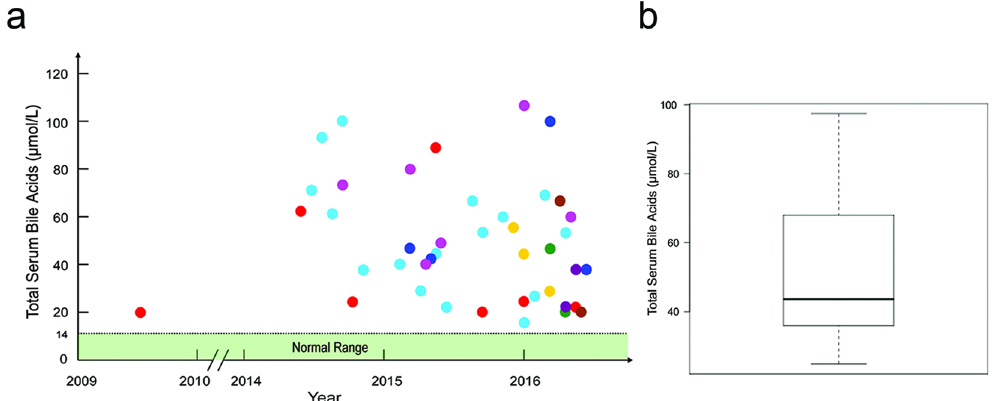
Figure 1. Levels of total serum bile acids (tsBAs) tested at the hospital lab and the Kingmed Diagnostics lab. ( a ) Scatter plots of tsBAs among the eight individuals who had a homozygous p.Ser267Phe genotype in SLC10A1 tested at the hospital lab. All tests were performed on serum from blood taken first thing in the morning after at least 8 hours of fasting. Red dot: individual 1, light blue: individual 2, dark blue: individual 3, light purple: individual 4, yellow: individual 5, dark green: individual 6, brown: individual 7, and dark purple: individual 8. The light green area shows the normal range for total serum bile acids (0–14 μ mol/L) according to the hospital laboratory standards. ( b ) Boxplot of tsBAs among the eight individuals who had a homozygous p.Ser267Phe genotype in SLC10A1 according to the Kingmed Diagnostics Lab measurements. The boxplot shows the median, range, and inter-quartile range of tsBAs levels across these